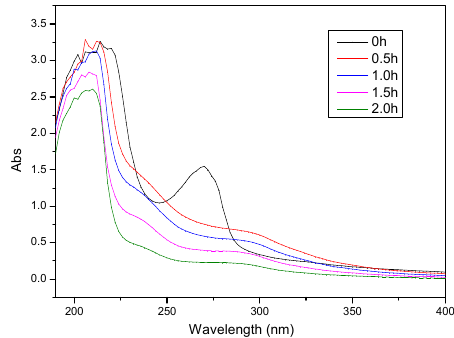
Figure 12. UV–VIS spectral change of oil refinery wastewater with different degradation times.